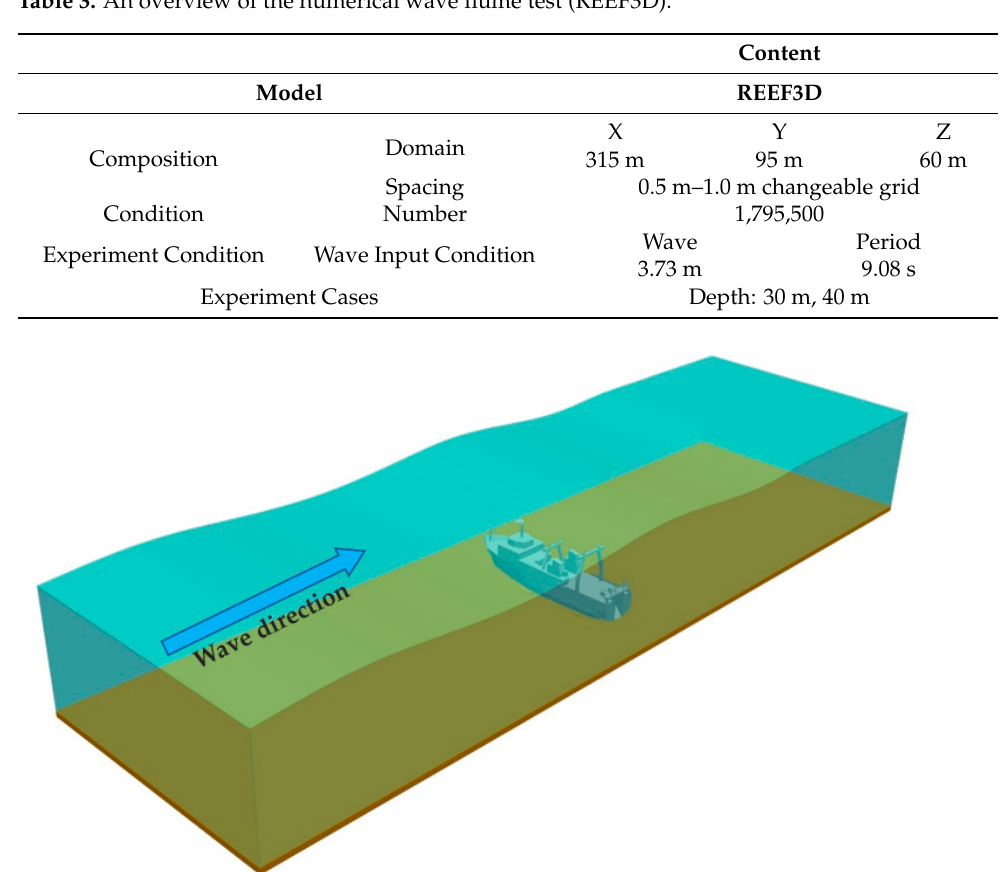
simulation as shown in Figure